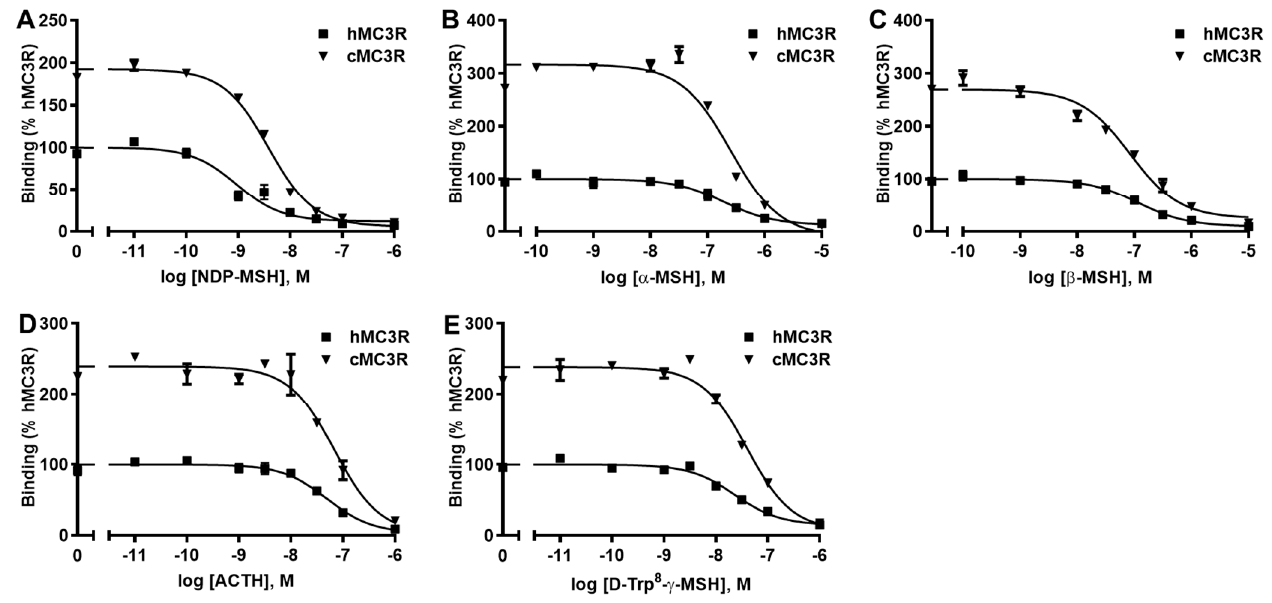
Figure 4. Ligand binding properties of cMC3R. Different concentrations of unlabeled NDP-MSH ( A ), α -MSH ( B ), β -MSH ( C ), ACTH (1-24) ( D ), and D-Trp 8 - γ -MSH ( E ) were used to displace the binding of 125 I-NDP-MSH. Results are expressed as % of hMC3R binding ± range from duplicate determinations within one experiment. All experiments were repeated at least three independent times. Table 1. The ligand binding properties of cMC3R.